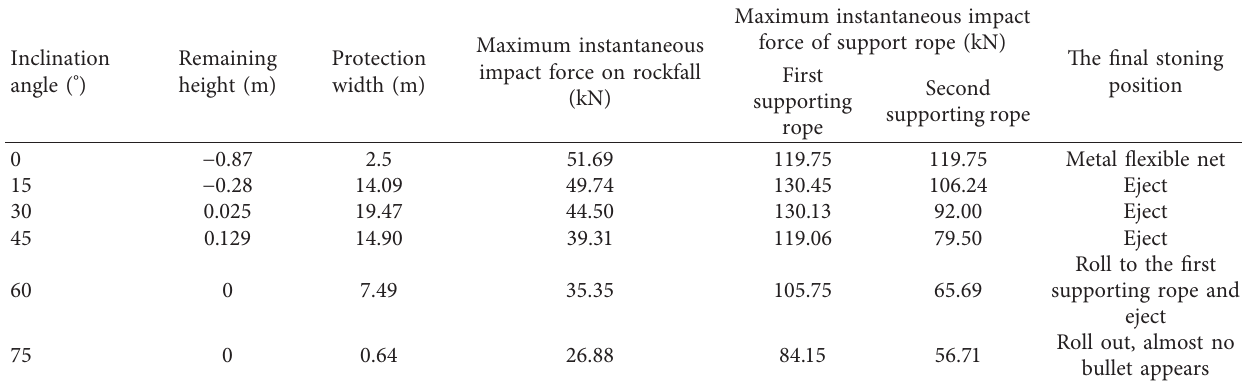
Table 5: The antirock fall impact performance under different impact